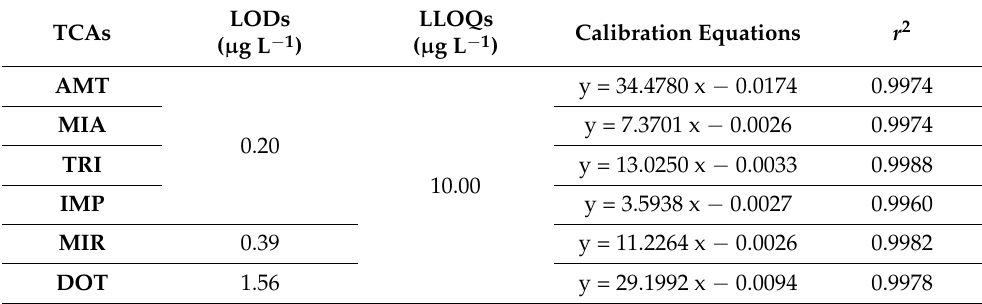
Table 2. LODs, LLOQs, calibration equations and r 2 achieved for the six TCAs through BA µ E(C18)- µ LD/LVI-GC-MS(SIM) methodology, under optimized experimental conditions.